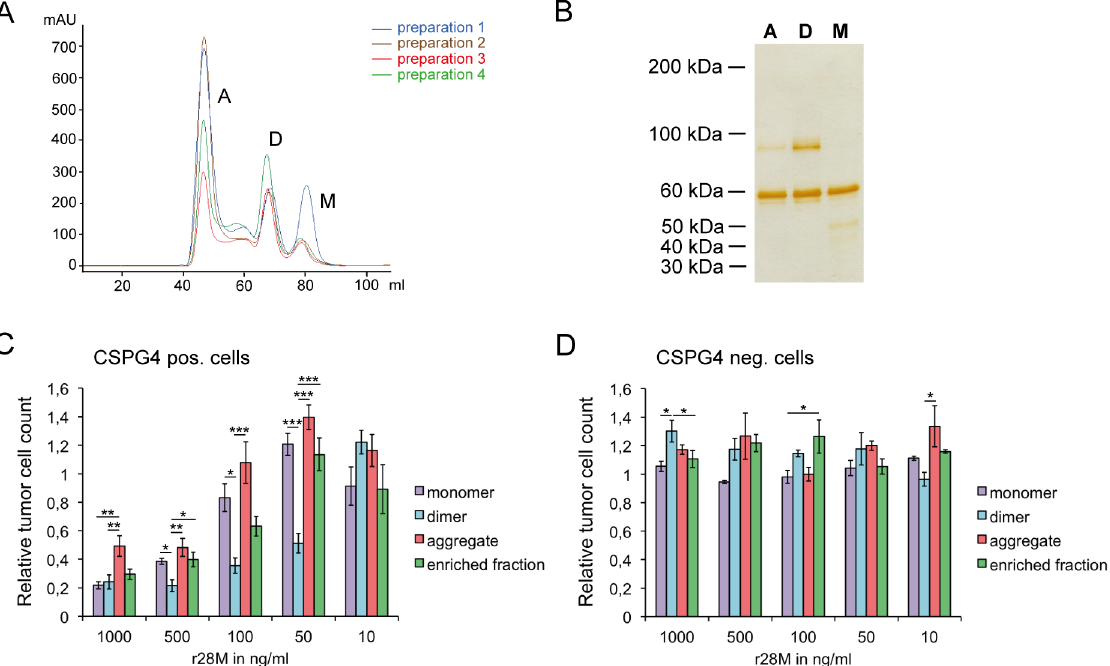
Fig 4. Analysis of the different r28M fractions after size exclusion chromatography (SEC). (A) The chromatograms of 4 independent purification batches after separation via SEC show the monomer (M), dimer (D) and aggregate (A) fractions. (B) Silver staining of the fractions (500 ng per lane) separated by SDS-PAGE under non-reducing conditions. A = aggregate, D = dimer, M = monomer. Results are shown from one representative out of 10 independent experiments. ( C and D) CSPG4 positive cells (IPC-298) (C) as well as CSPG4 negative cells (U-251 MG) (D) were incubated together with PBMC and 10 – 1000 ng/ml of the different r28M fractions in a final volume of 150 μ l/well. After 72 hrs the amount of viable tumor cells was determined. Results show samples normalized to the controls. Cells incubated without r28M served as controls, their number was considered as 1. Values are means ± SE. Significance levels: x: p (cid:1) 0.05; xx: p (cid:1) 0.01; xxx: p (cid:1) 0.001.